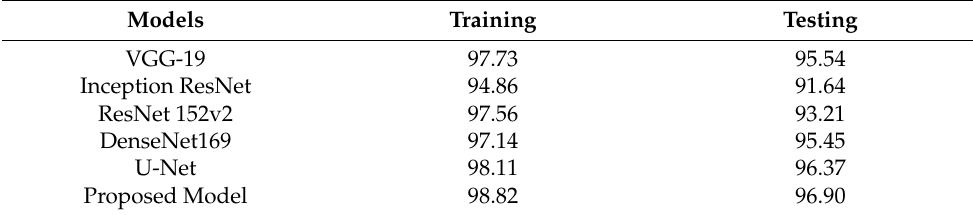
Table 1. An analysis of the effectiveness of the